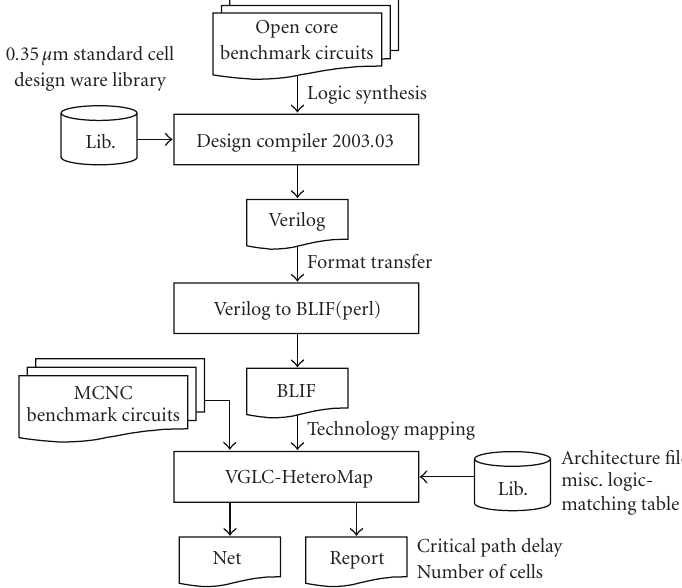
Figure 13: Architecture evaluation flow.